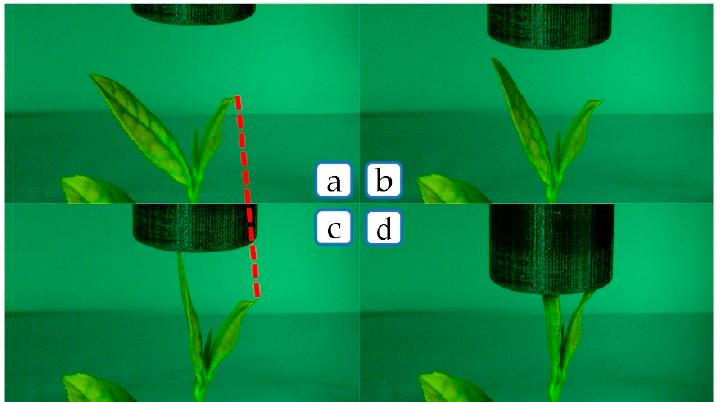
Figure 15. Descent position is the tip of the apical bud. ( a ) initial state, ( b ) Guidance start, ( c ) During guidance, ( d ) End of guidance.